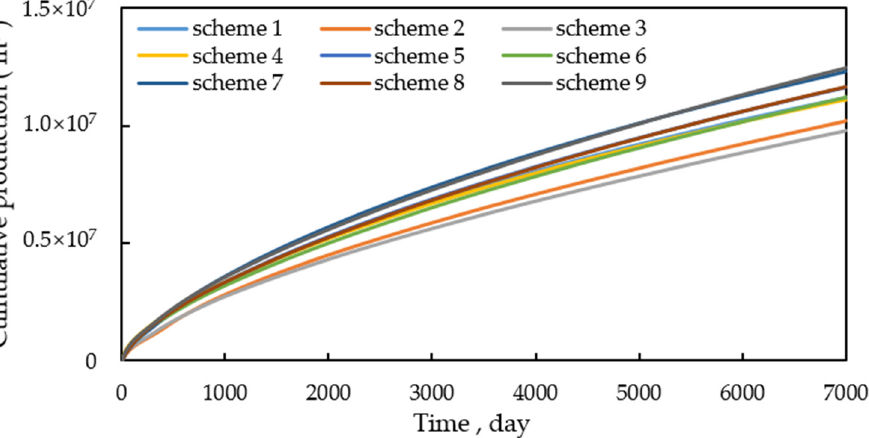
Figure 17. Cumulative gas production curve of single well after different development schemes of vertical well.